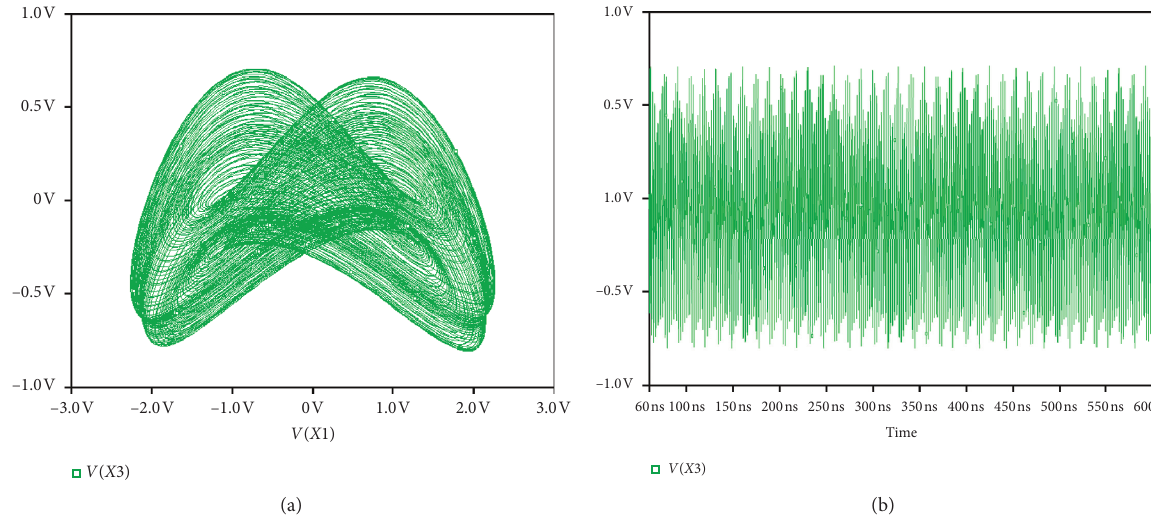
Figure 14: Periodic orbit observed from the analog circuit of the novel system for R V � 0 . 8V: (a) x b